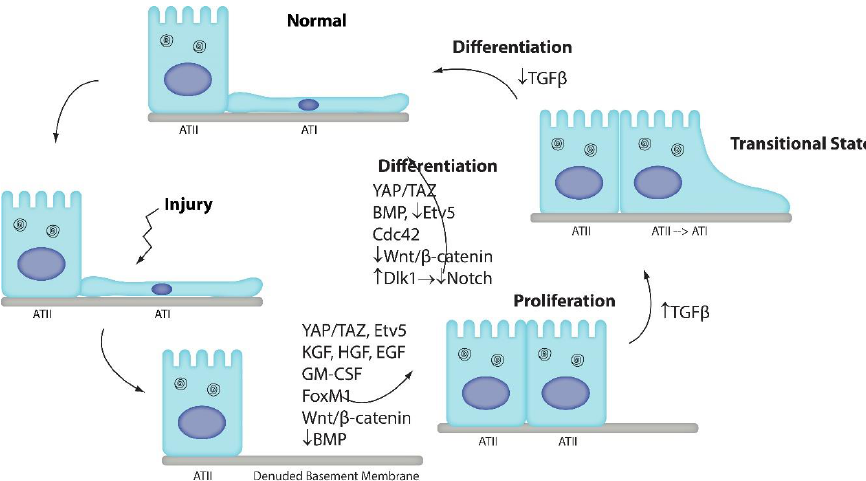
Figure 1. The alveolar epithelium consists of ATI and ATII cells. ATI cells are very susceptible to injury. ATII cells regenerate ATI cells. ATII cells proliferate and then differentiate into ATI cells. Many pathways have been identified that promote ATII cell proliferation: KGF [16], HGF [17,54], EGF [19,20], GM-CSF [33], FoxM1 [10], Wnt / β -catenin [13–15], Etv5 [37], and YAP / TAZ [24,26], whereas downregulation of BMP in ATII-to-ATI cell differentiation: YAP / TAZ [24,26], Cdc42 [35], and BMP [23] promote